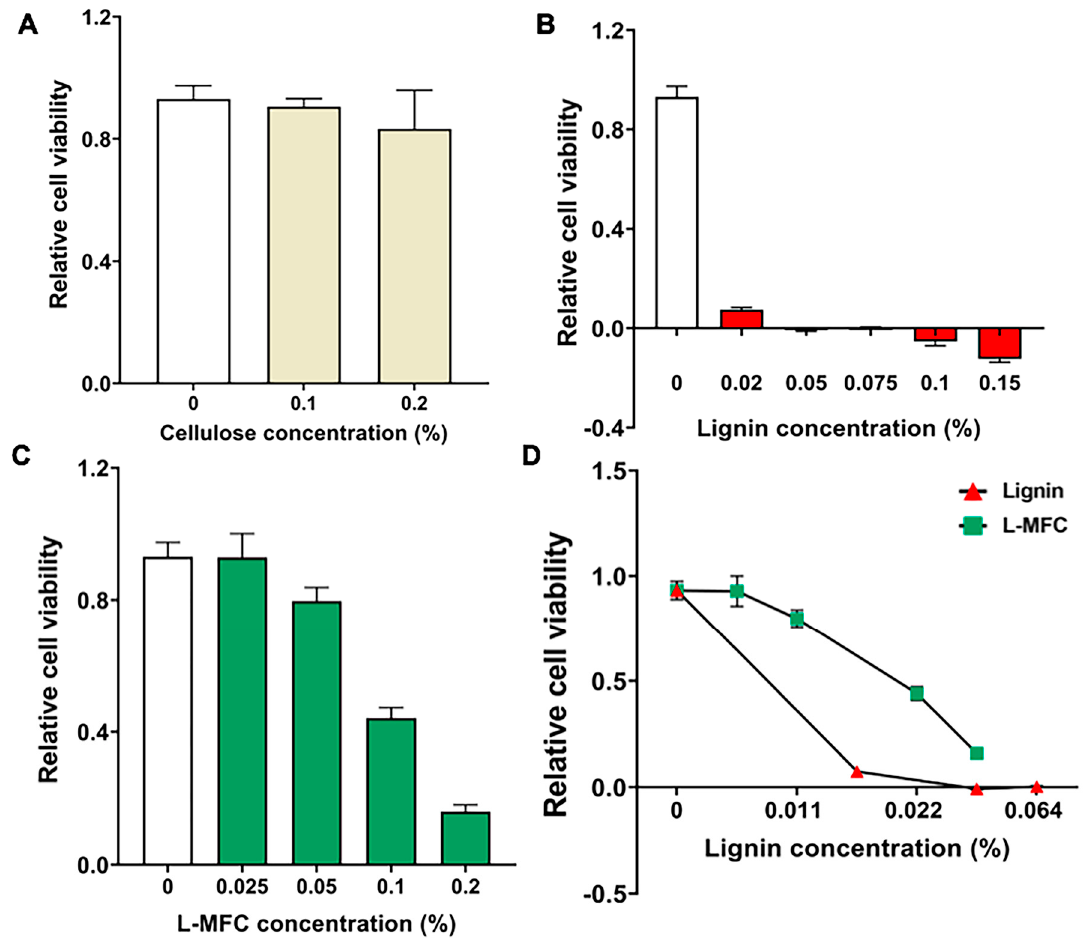
Figure 2. Toxicity of cellulose, L-MFC, and lignin in HEK293 cells. ( A ) Water-soluble tetrazolium salt (WST) assay results with cellulose at concentrations 0, 0.1 and 0.2%. Error bars show standard deviation (s. d.; n = 12 biological replicates). ( B ) WST assay results with lignin in increasing amounts showing marked cytotoxicity. Error bars show s. d. (n = 12). ( C ) WST assay results with L-MFC. Error bars show s. d. (n = 12). ( D ) Comparison between pure lignin and lignin contained in L-MFC for cytotoxicity. Error bars show s. d. (n = 3). Table 3. LC 50 value of L-MFC in HEK293 cells.